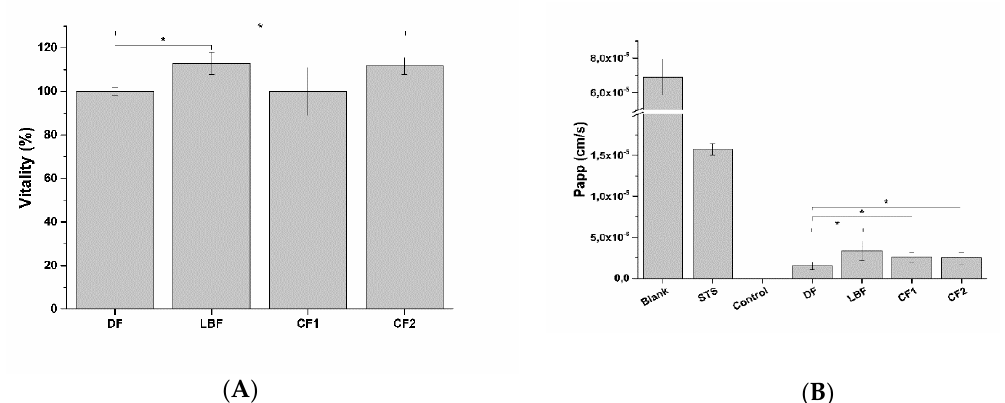
Figure 11. Cell vitality ( A ) and apparent permeability (P app ) ( B ) of intestinal epithelium exposed to digestive fluids (DF; control) and digested formulations ( n = 3). LBF is composed of SRO, PAC, and lycopene bioaccessible fractions as reported in Tables 5 and 6. CF1 and CF2 represent the bioaccessible fractions as reported in Table 3.